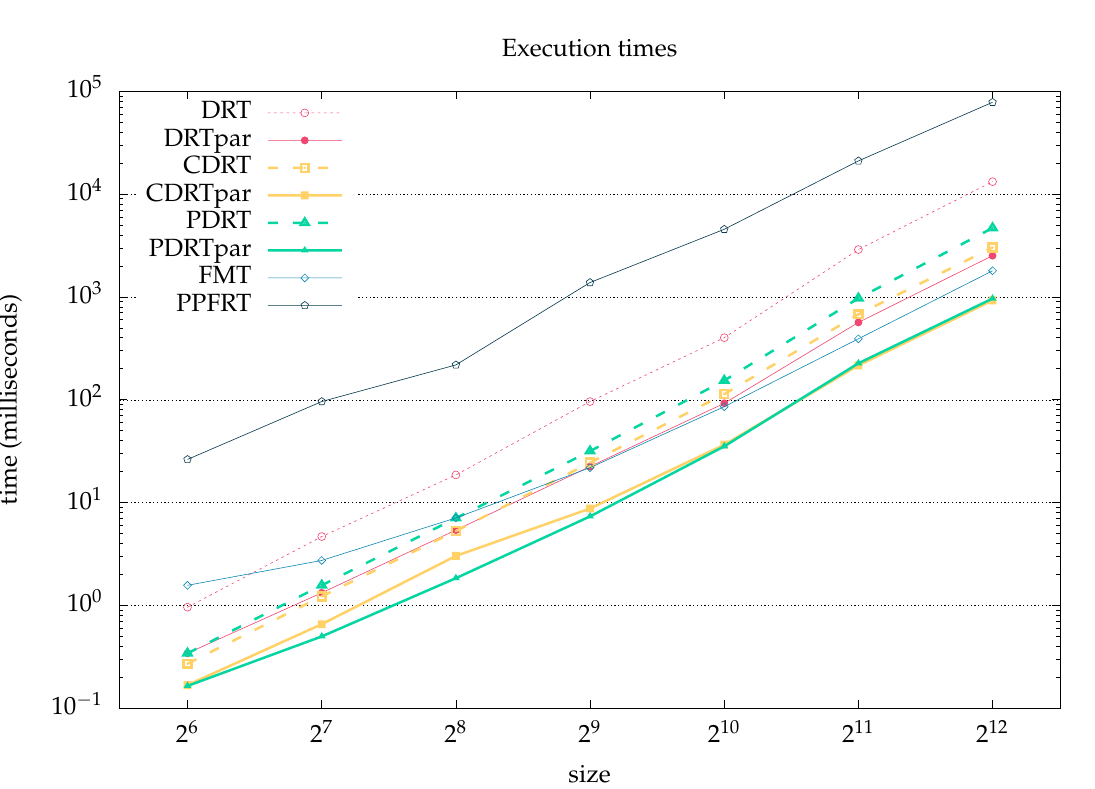
Figure 14. Log–log representation of execution times (in milliseconds) for different algorithms and sizes of input on the same CPU platform. DRT stands for conventional DRT, whilst CDRT and PDRT are our proposed central and periodic DRT. FMT stands for fast Mojette transform. PPFRT stands for pseudo-polar Fourier-based Radon transform; par stands for parallel